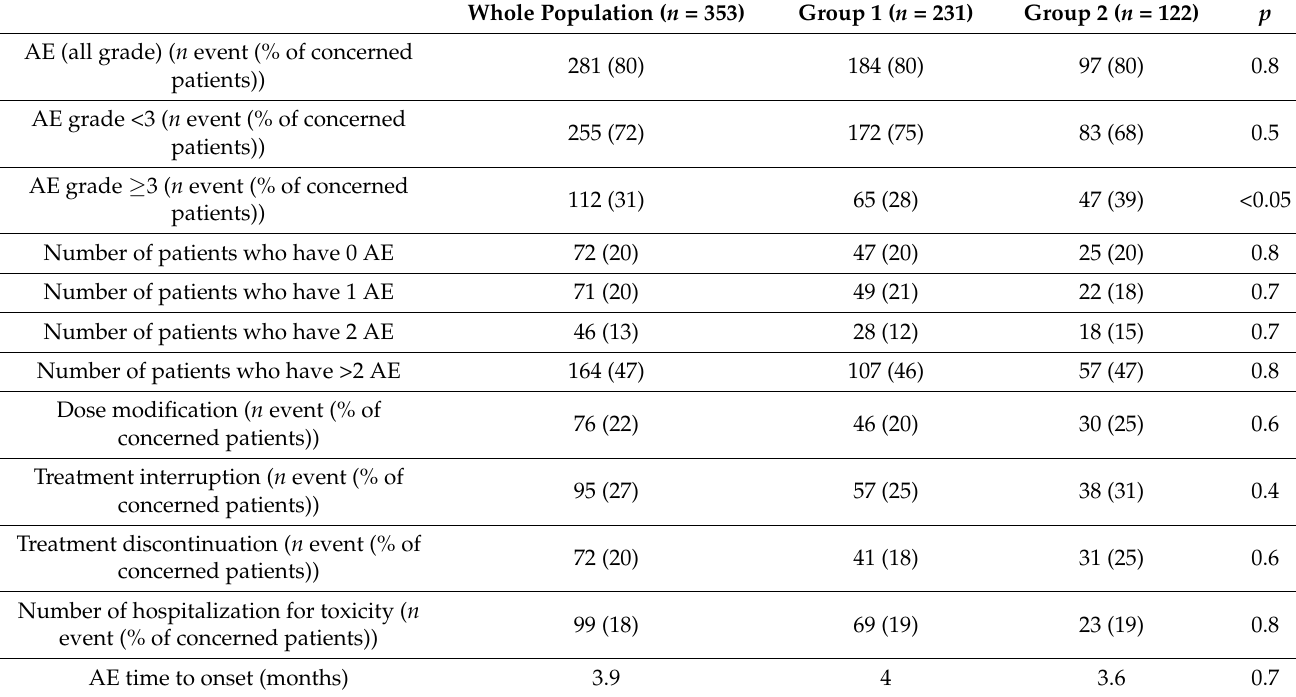
Table 2. Number of events and proportions of patients concerned for all grades adverse effects, grade < 3, grade ≥ 3, dose modification, interruption, discontinuation, hospitalization for BRAF, and MEK inhibitors among the two age groups and whole